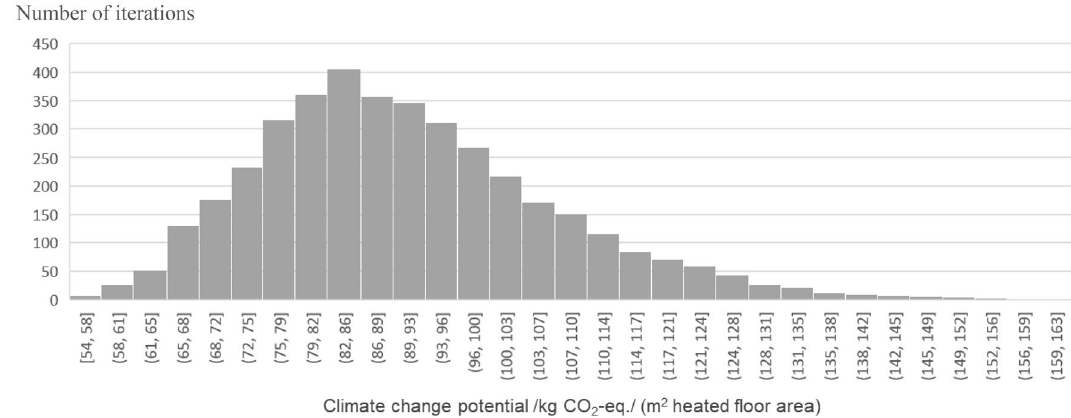
Fig. 3 Frequency diagram for 4000